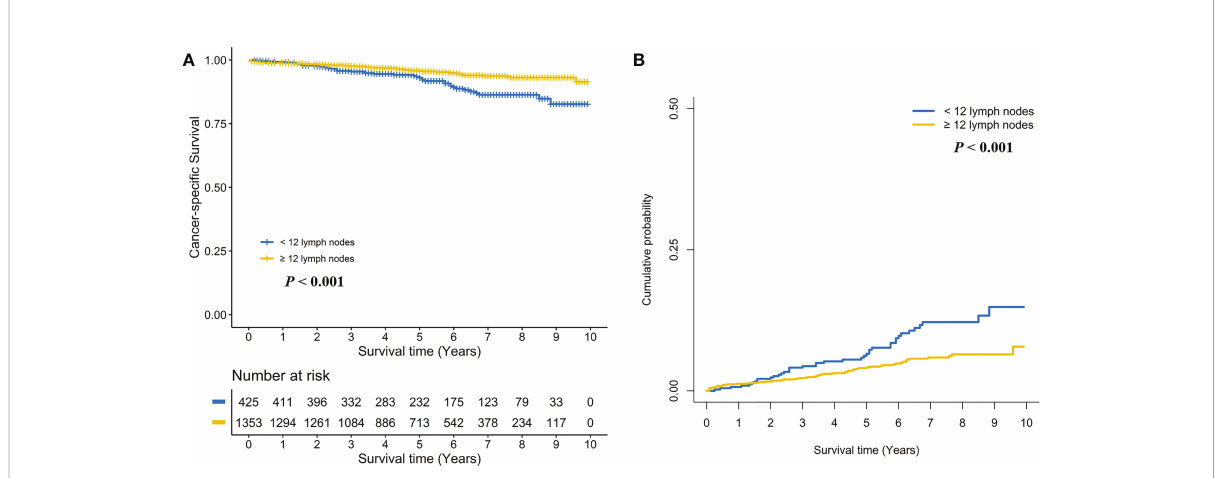
FIGURE 2 Comparison of cancer-speci fi c survival (A) and cumulative probability of cancer-speci fi c death (B) in stage I rectal cancer patients between < 12 and ≥ 12 lymph nodes